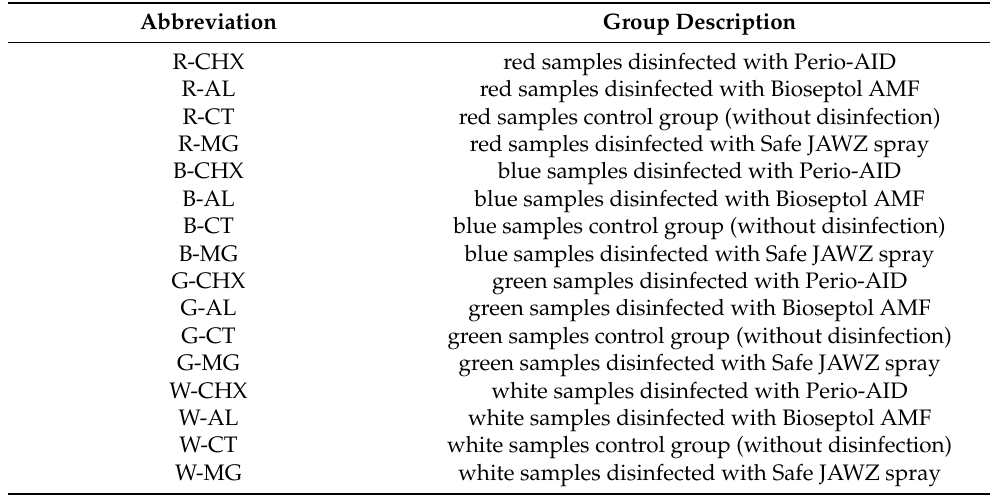
Table 2. Abbreviations for groups in disinfection protocol.